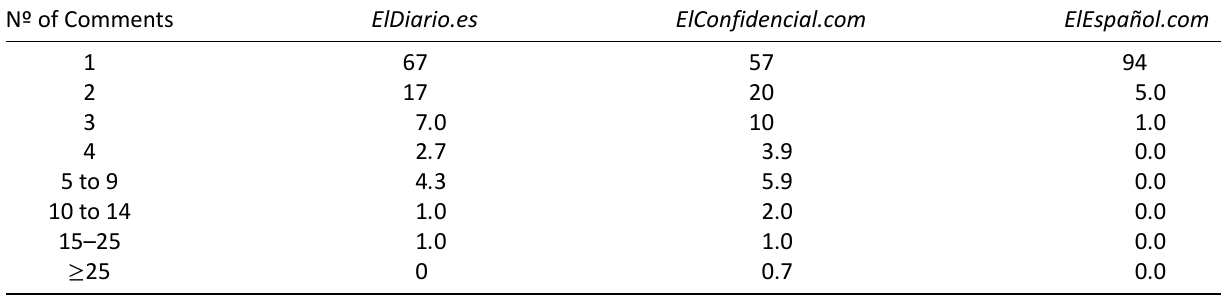
Table 3. Frequency of comments per users